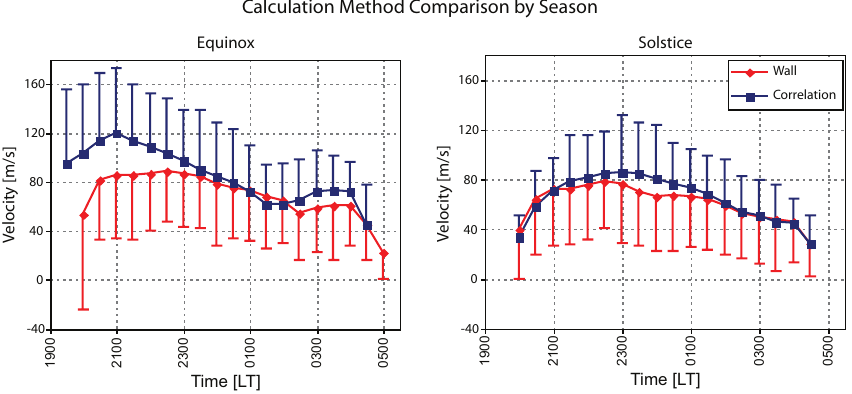
Fig. 3. Comparison of velocity calculation routines on quiet time data, divided by season, with equinox averages on the left and June solstice averages on the right. A maximum difference of around 40% is observed during the equinox, compared with a maximum difference of around 20% during the June solstice